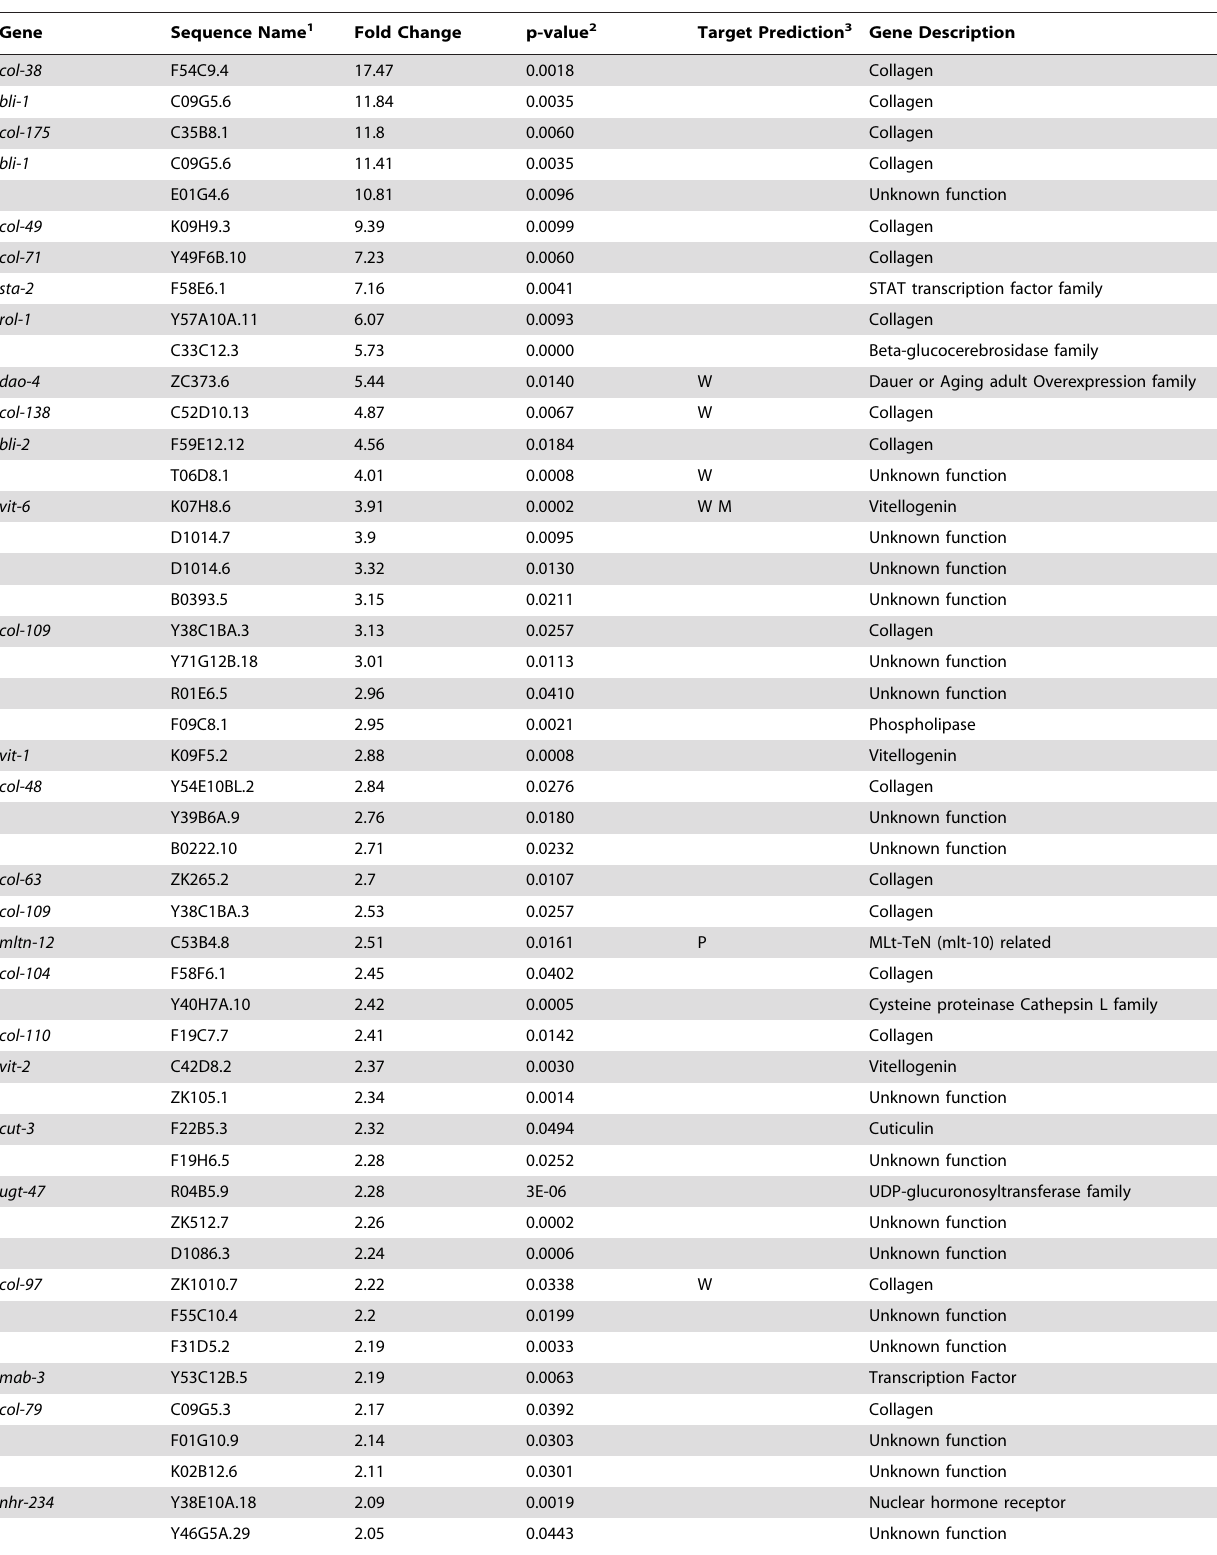
Table 2. Genes down-regulated more than 2-fold in let-7(n2853) compared to wild-type.